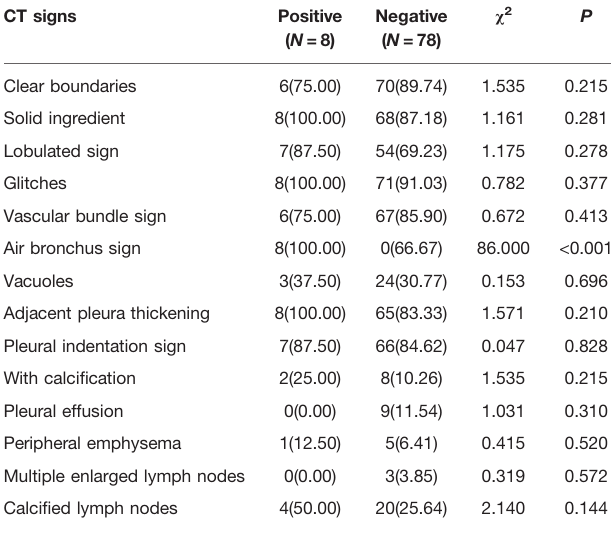
TABLE 2 | Relationship between different CT signs and nerve invasion in patients with lung adenocarcinoma [ n (%)].